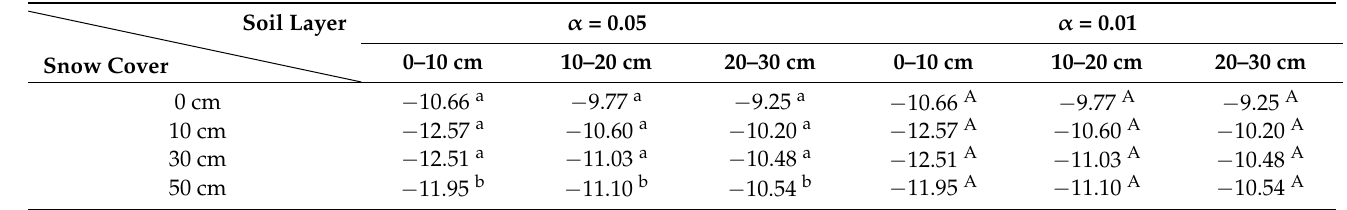
Table 4. Differences in the isotope values of the soil water in the same soil layer for different snow depths.